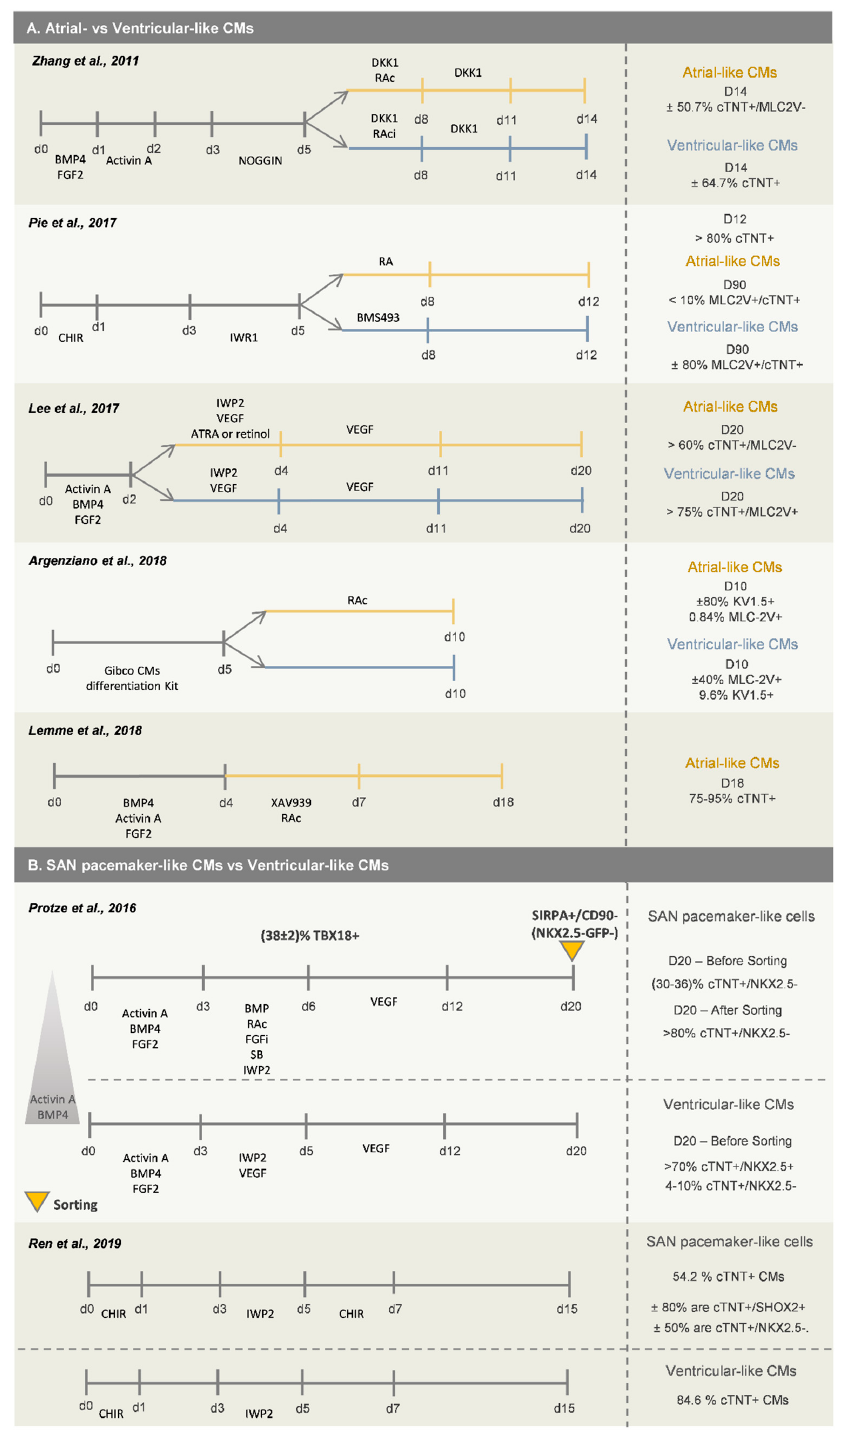
Figure 3. Current in vitro strategies to generate different CM subtypes from hPSCs. Protocols for generation of ( A ) atrial-like and ( B ) SAN pacemaker-like CM subtypes. ATRA, all-trans-retinoic acid.